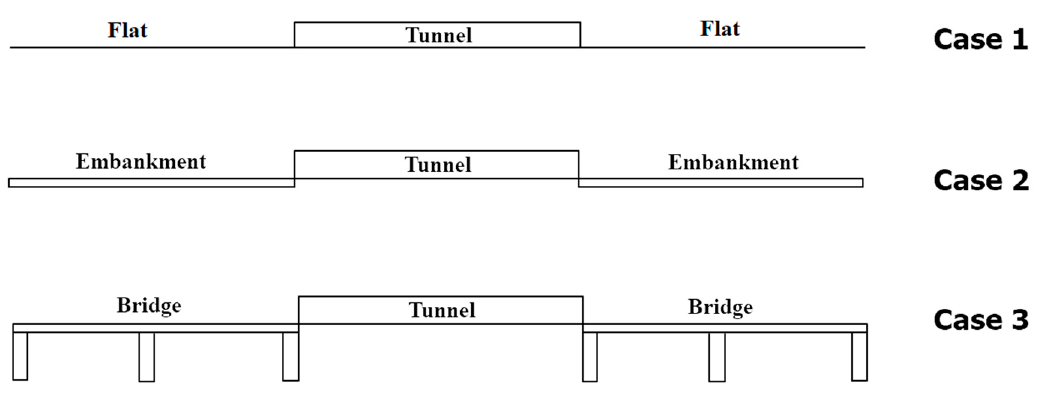
Figure 2. Schematic of three junction scenarios. Figure 1. Schematic of three junction